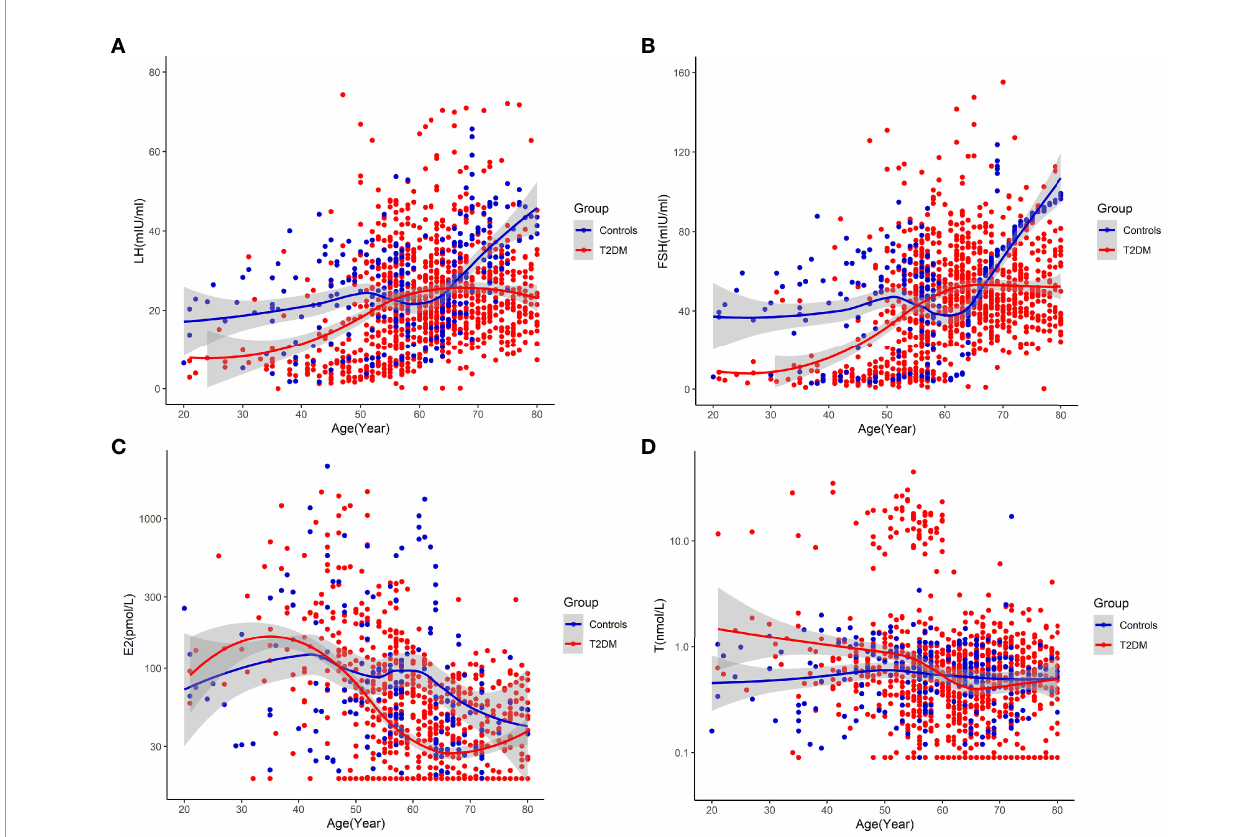
FIGURE 2 | Temporal trends in circulating sex hormones across age groups in patients with T2DM and non-T2DM controls [ (A) Temporal trends in circulating LH across age groups. (B) Temporal trends in circulating FSH across age groups. (C) Temporal trends in circulating E2 across age groups. (D) Temporal trends in circulating testosterone (T) across age